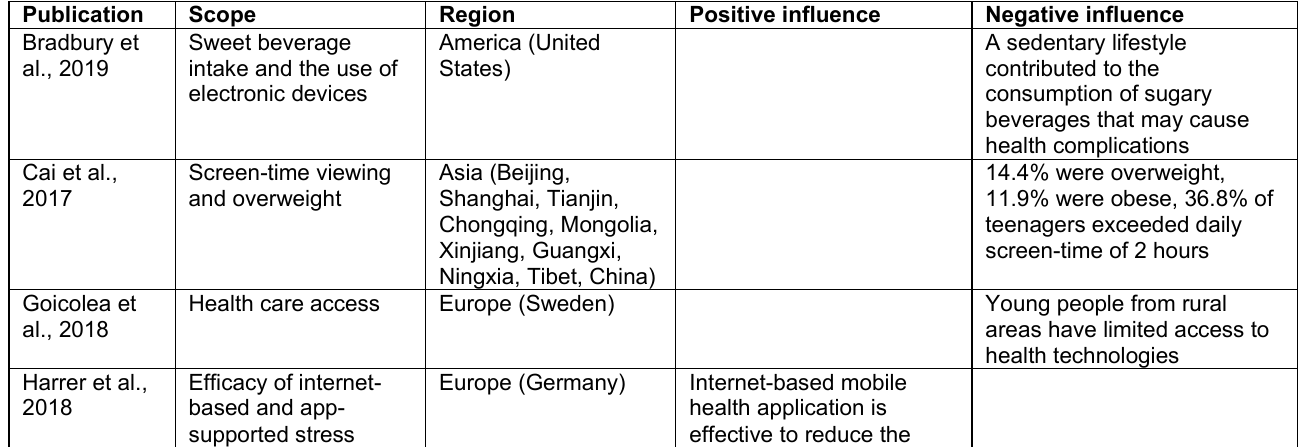
Table 3. Studies on the influence of ICT on